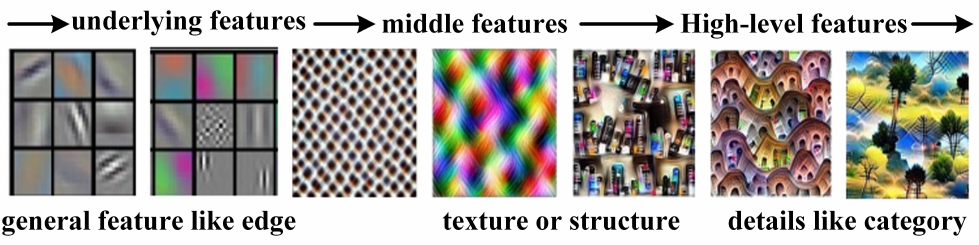
Figure 3. Feature extraction in